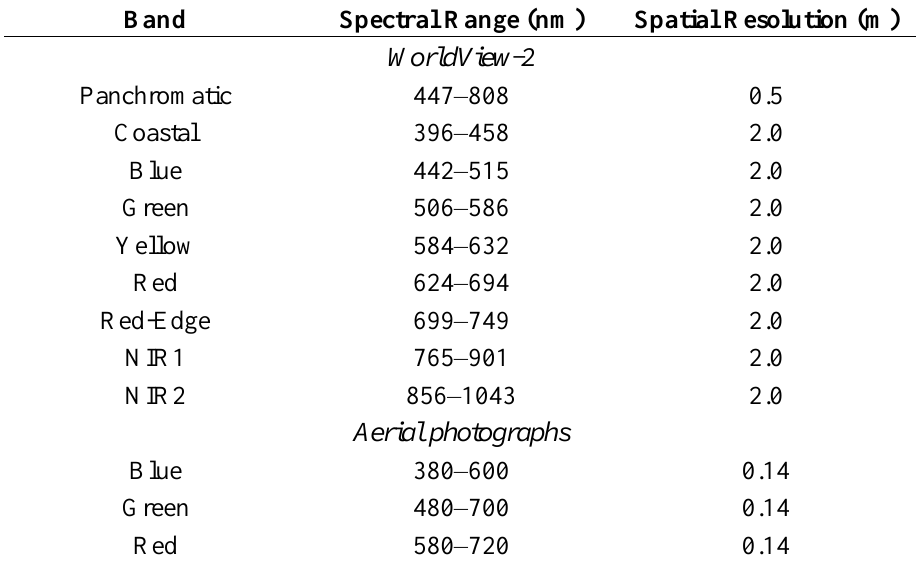
Table 1. Spectral band information of WV2 image and aerial photographs obtained from UltraCamD camera